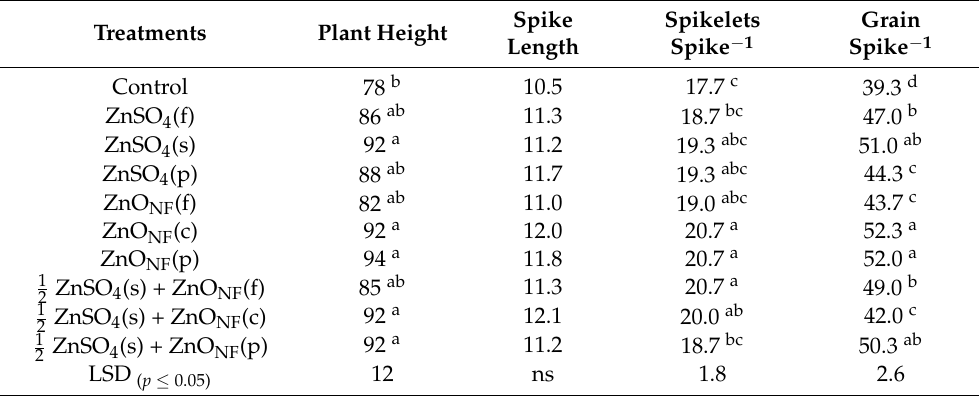
Table 2. Plant height, spike length, spikelets per spike, and grains per spike of wheat as affected by different modes and sources of Zn